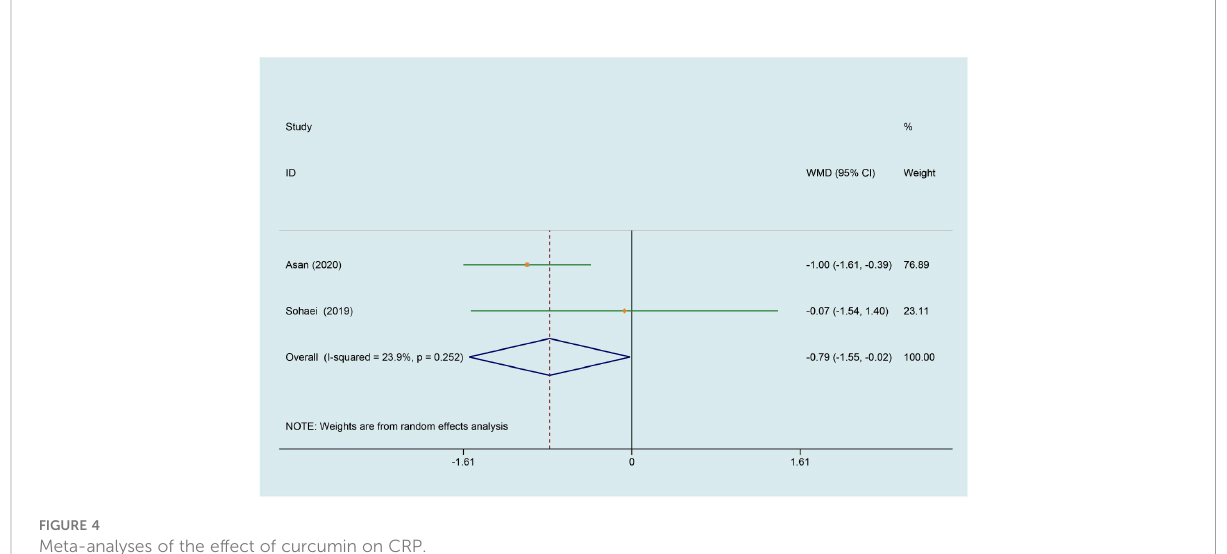
FIGURE 4 Meta-analyses of the effect of curcumin on